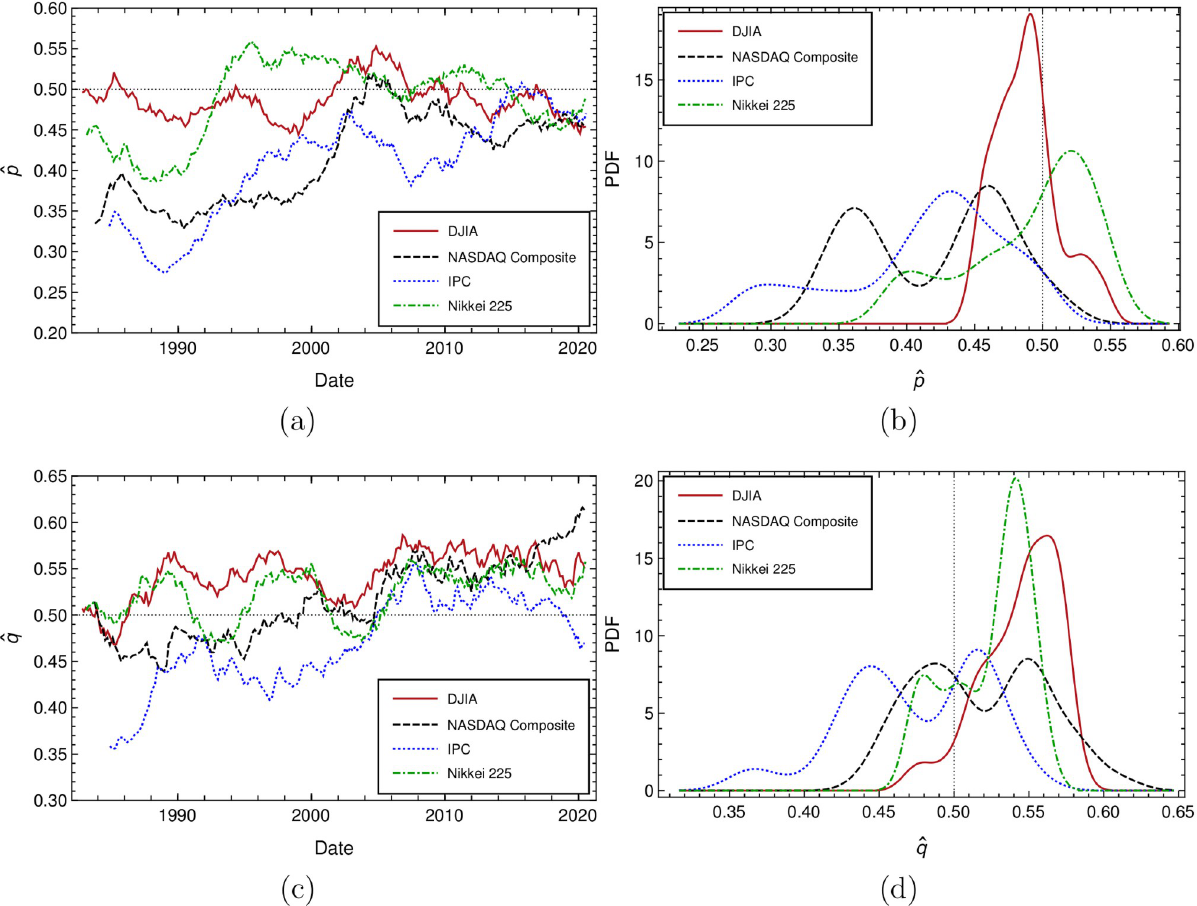
Fig 5. 5(a): p variation over time calculated for all data samples with a time window of 252 days shifted each 10 trading days. 5(b): Empirical distributions of p from left subfigure. 5(c): q evolution in time for all analyzed data samples. 5(d): Empirical distributions of q from left subfigure.